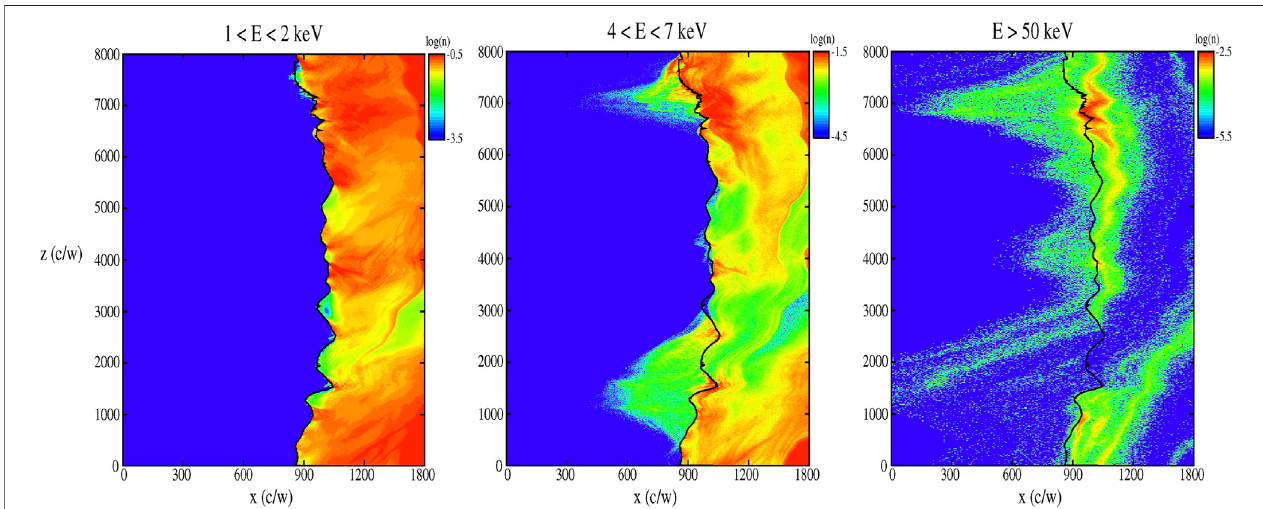
FIGURE2| Ahybridsimulationofaquasi-perpendicularshock ( < θ Bn > (cid:1) 70 + ) ,withparametersconsistentwiththoseoftheDOY118,2001interplanetaryshock measured by ACE. Shown are suprathermal proton densities at Ω ci t (cid:1) 500 with energies measured in local plasma frame. This result is similar to Giacalone (2005).